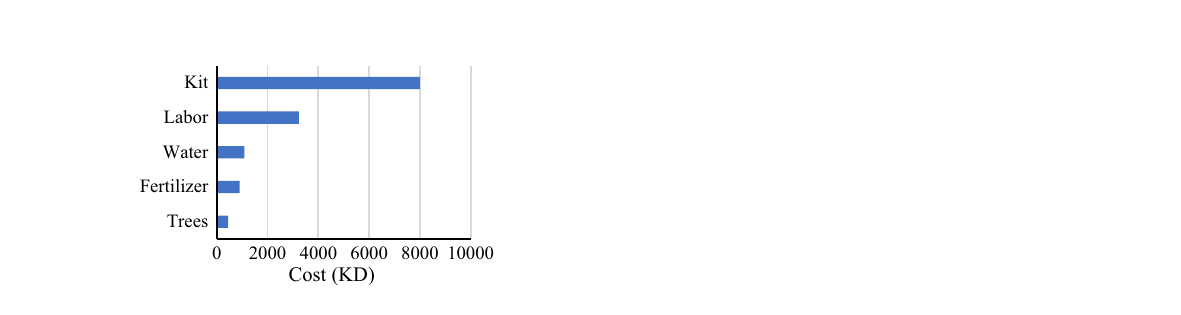
Figure 6. Pareto’s Law of the Cost